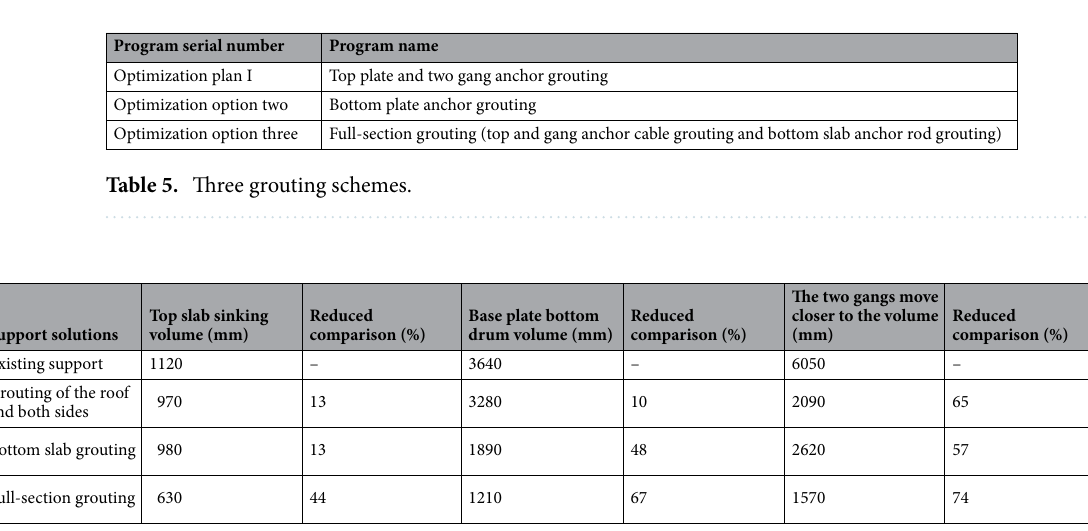
Table 6. Comparison between existing support and three grouting optimization